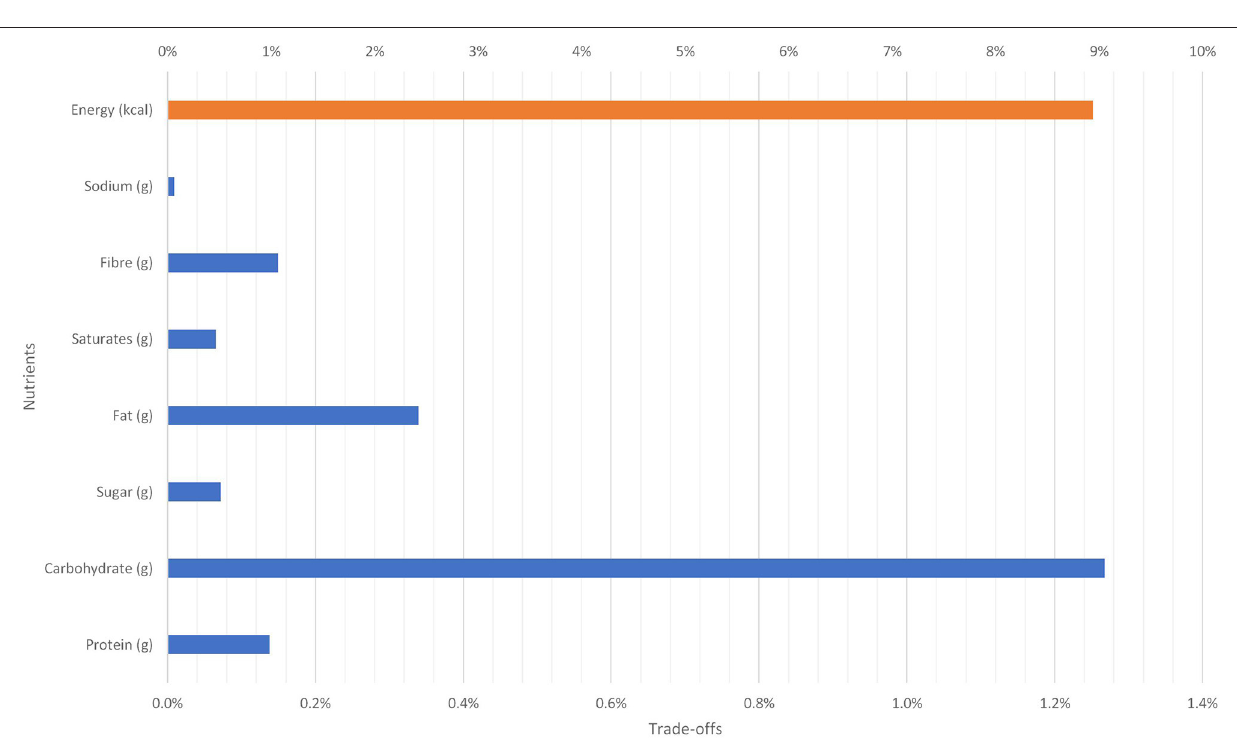
Frontiers in Nutrition |